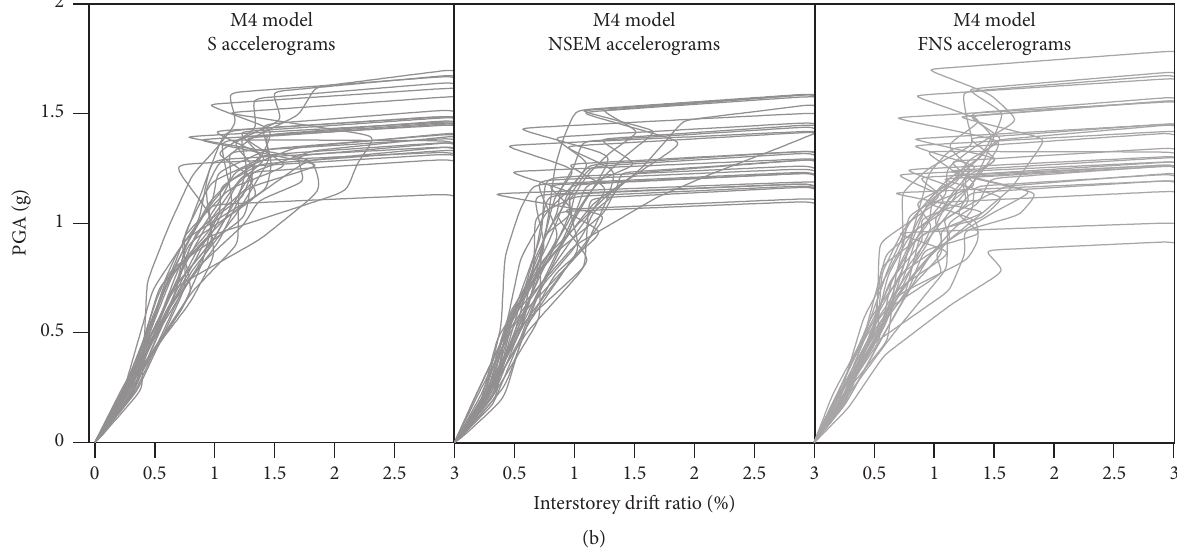
Figure 9: IDA curves (PGA vs. maximum interstorey first-floor drift ratio) for the M1 (a) and M4 (b) models for the 3 types of artificial ground motion.